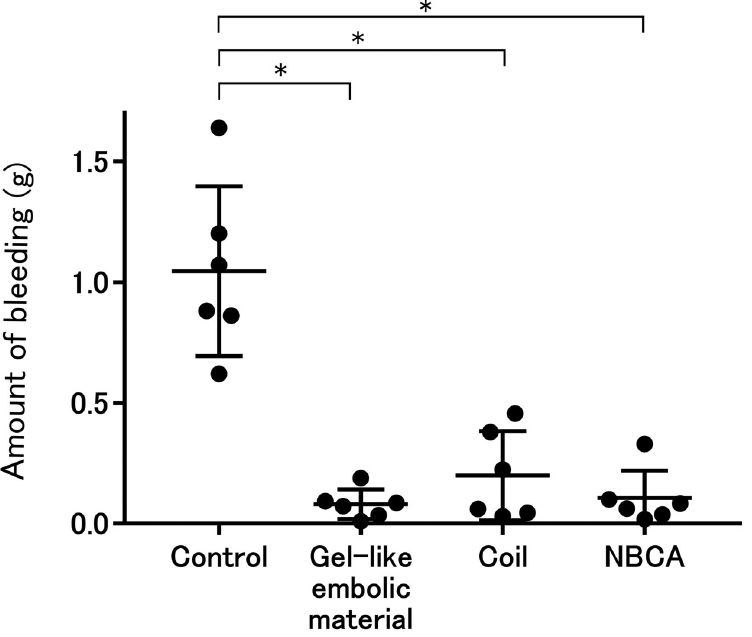
Fig 4. Comparison of the amount of bleeding after puncture of the rabbit kidney. � p < 0.0083: control vs. gel-like embolic material, p = 0.0007; control vs. NBCA, p = 0.0027; control vs. coil, p = 0.0013; gel-like embolic material vs NBCA, p = 0.4848; gel-like embolic material vs coil, p = 0.9372; NBCA vs coil, p = 0.5887.